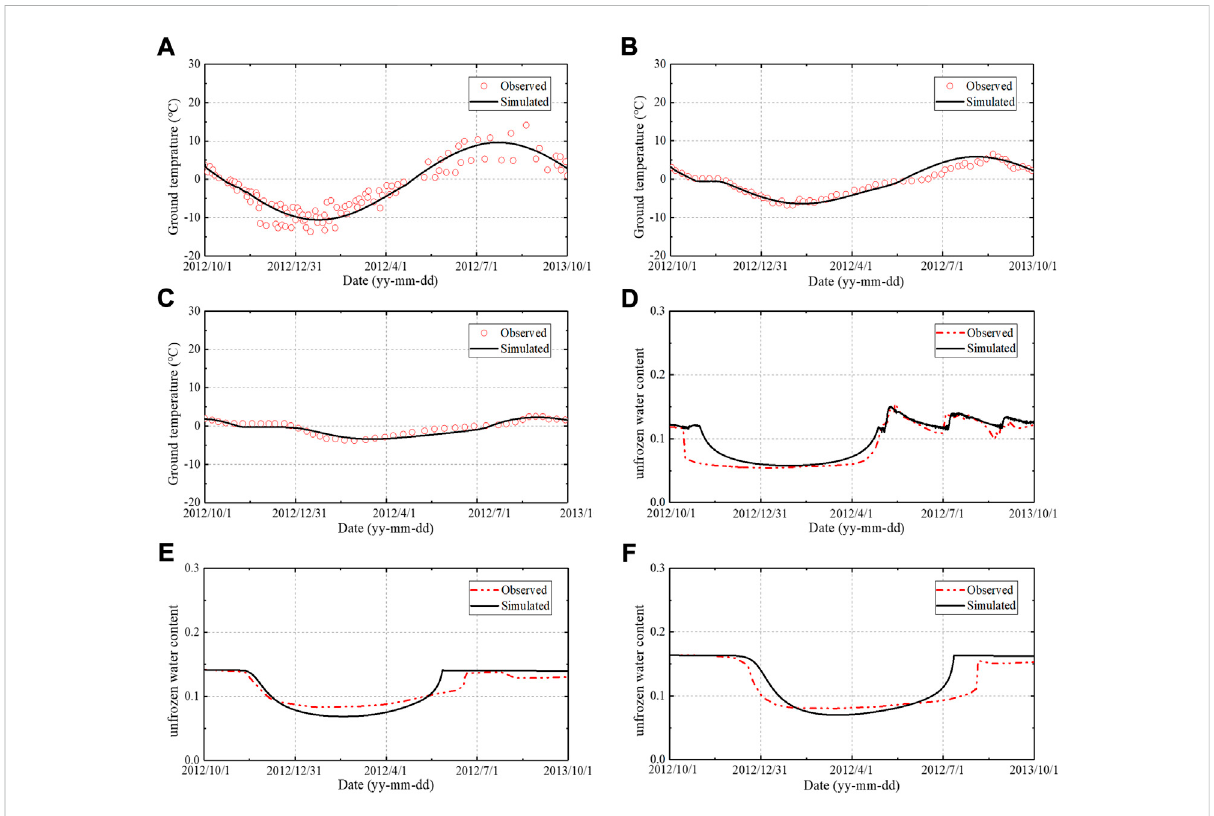
FIGURE 3 Variation of measured and calculated ground temperature at (A) 0.15 m, (B) 0.75 m, (C) 1.50 m, and measured and calculated unfrozen water content at (D) 0.05 m, (E) 0.75 m, (F) 1.50 m.